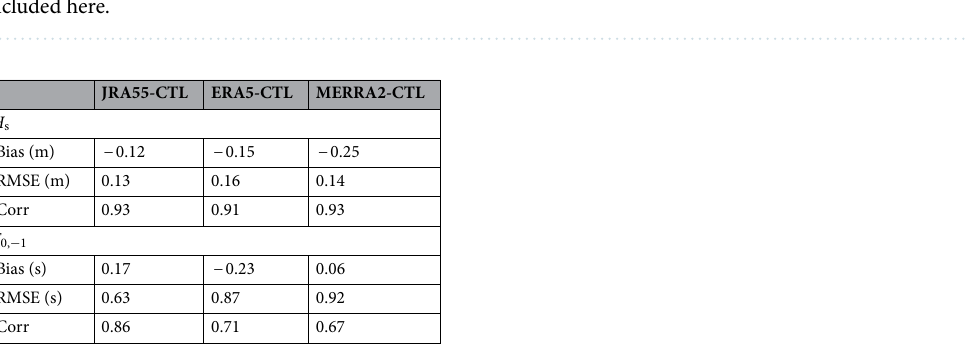
Table 3. Statistical values of H s and T 0, − 1 between the three model simulations (CTL runs) and buoy observations for monthly mean data. The number of validation data points was